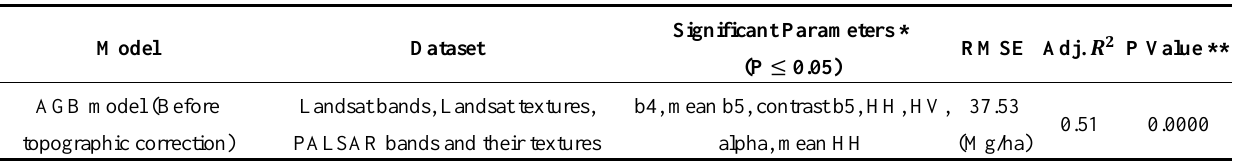
Table 5. Statistics summary of forest AGB estimation model based on uncorrected ETM+ data.